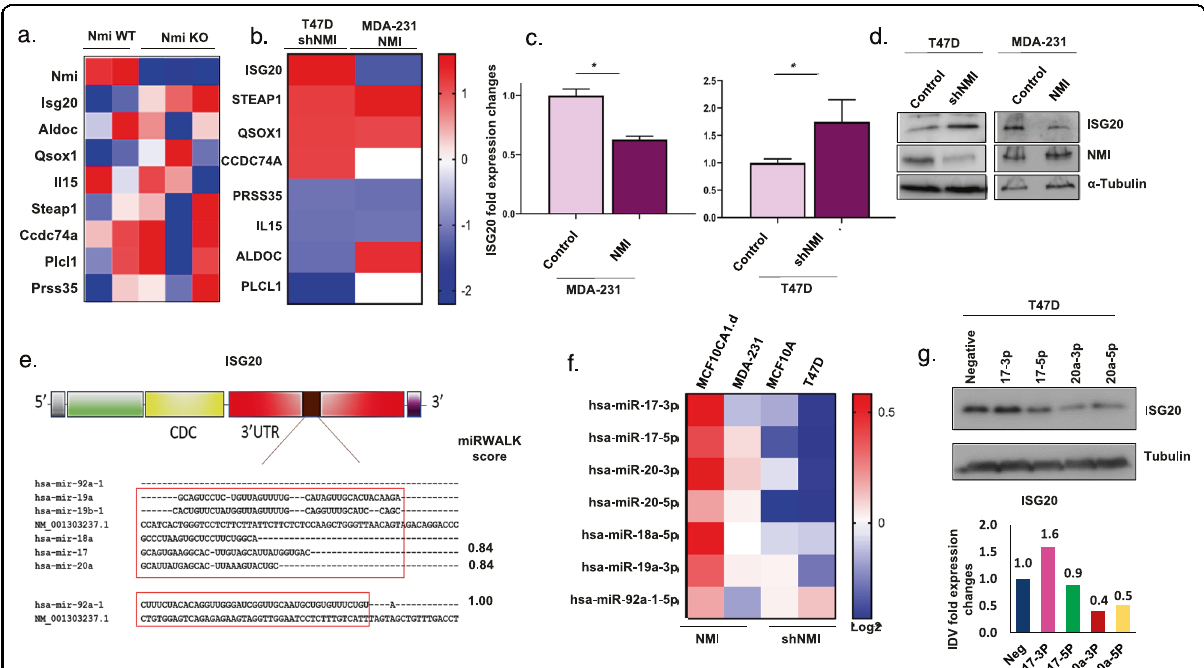
Fig. 5 NMI/STAT5A axis downregulate ISG20 through miRNA hsa-miR-20. a Heatmap of RNA-seq expression of STAT5 enhancer related genes in mammary mouse tissues for wild-type ( n = 2) vs NMI KO ( n = 3) mice mammary tissue. b Heatmap of fold change RNA-seq expression of Stat5 enhancer related genes in T47D shNMI vs control and 231 NMI vs control. c Fold expression changes of ISG20 using RTq-PCR in T47D vector control and shNMI, MDA-MB-231 scrambled control and NMI, ISG20 expression was signi fi cantly higher in T47D shNMI ( p = 0.03) and lower in MDA-MB-231 NMI ( p ≤ 0.0001). d WB of ISG20 and NMI proteins in T47D control and shNMI and MDA-MB-231 control and NMI expressing cells. e Schematic illustration of ISG20 gene structure with predicted binding sites of miR-17 – 92 cluster at the 3 ’ UTR region. f Heatmap representing fold changes of miR-17 – 92 cluster expression in miRNA array for MCF10CA1cl.D NMI, MDA-MB-231 NMI, MCF10A shNMI, and T47D shNMI compared to controls, scale represents log2 fold changes. g Western blot of ISG20 in T47D cells 48 h after being supplemented with miRNA mimics (100 nM) Hsa-miR-17-3p, Hsa- miR-17-5p, Hsa-miR-20a-3p, or Hsa-miR-20a-5p. Graph represents IDV quanti fi cation fold